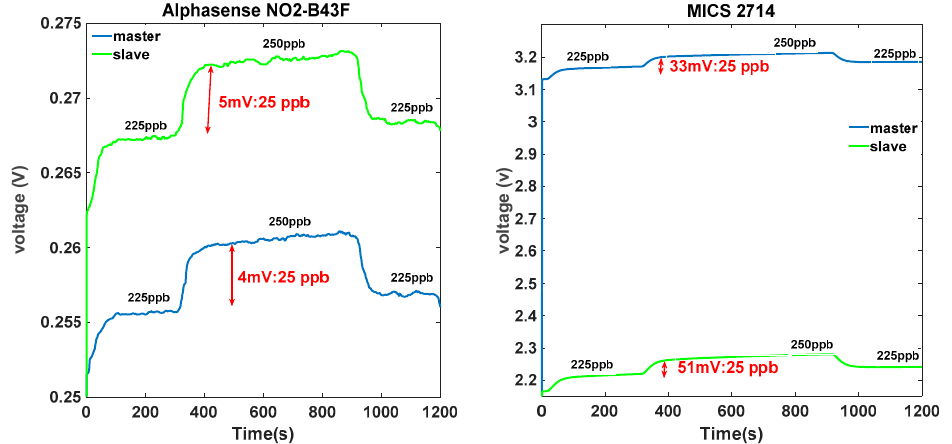
Figure 3. Acquired responses signals from identical sensors under the same conditions. ppb = parts per billion.